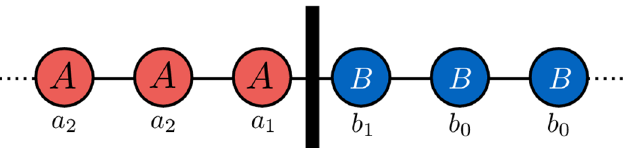
Fig 1. Payoffs at the boundary of two clusters in the cycle. Under weak selection, the cluster of A -players expands if the sigma rule a 1 + a 2 > b 1 + b 0 holds. As a player is never paired with two players of the opposite strategy, neither a 0 nor b 2 enter into this expression. This provides an intuition behind our analytical results in the simple case when the graph is a